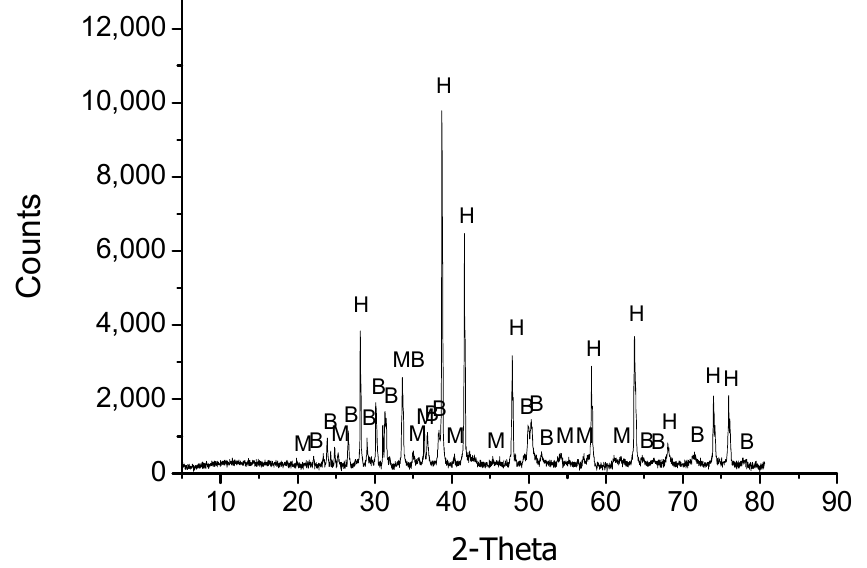
Figure 12. X-Ray diffraction of the solid residue of the aqueous leaching step of run 10 (H—hematite, M—monazite, B—barite).